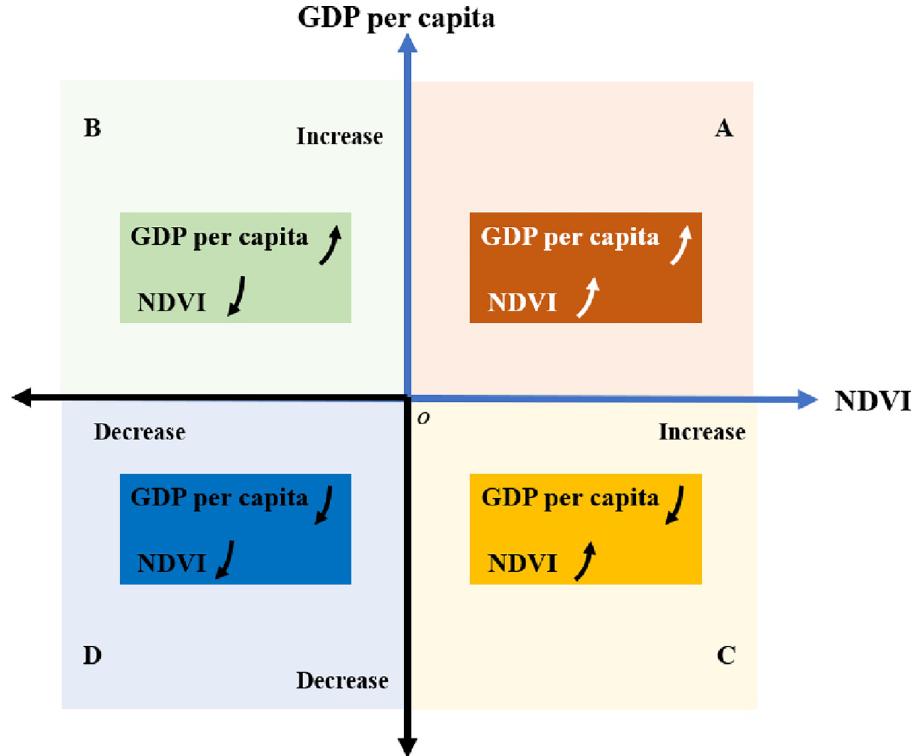
Fig 2. The framework of the evaluation of poverty alleviation policy on ecological